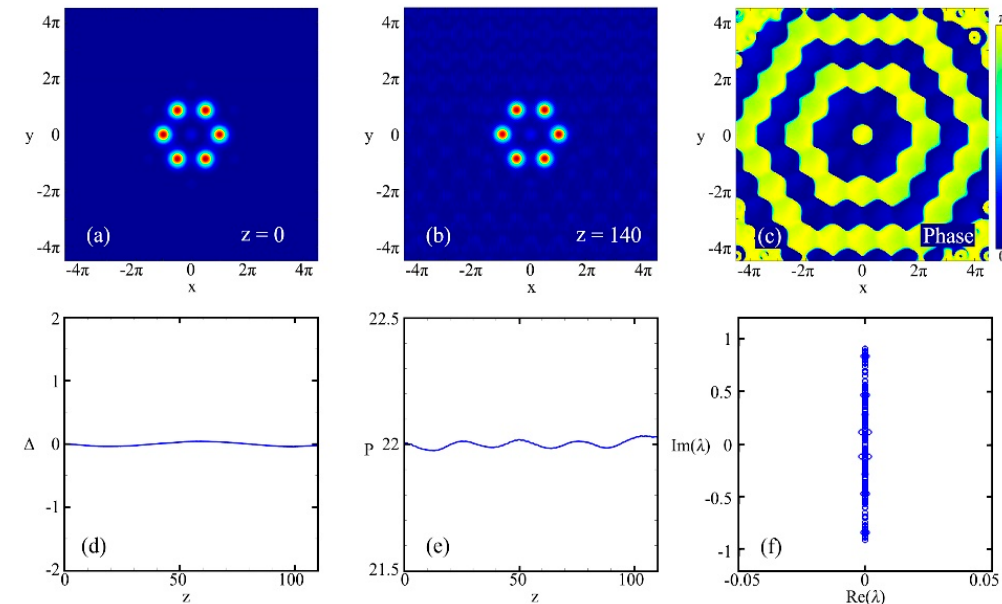
Figure 8. The evolution dynamics of stable six-pole solitons with d = 0.5, µ = 10. ( a , b ) correspond to the transverse profile of the solitons at z = 0 and z = 140, respectively. ( c ) shows the phase structure of the six-pole soliton. ( d , e ) correspond to ∆ and P during propagation. ( f ) shows the spectrum of the perturbation growth rates.